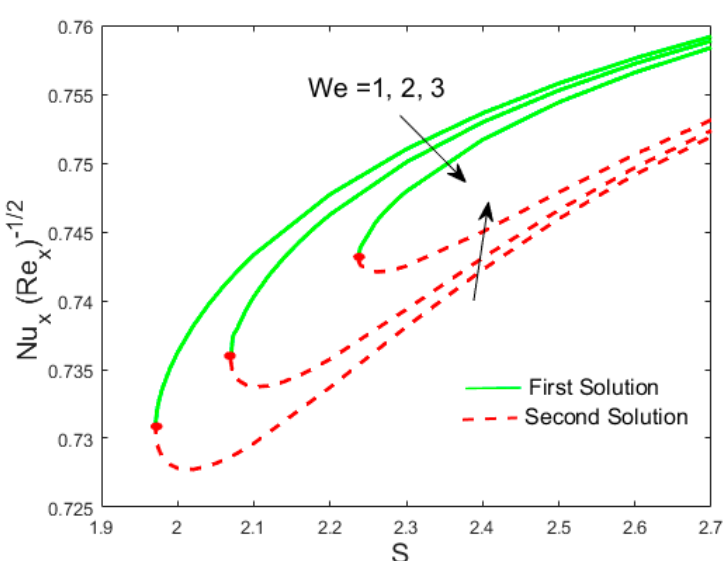
Figure 14. Impact of We versus S on C fx Re 1/2 x .